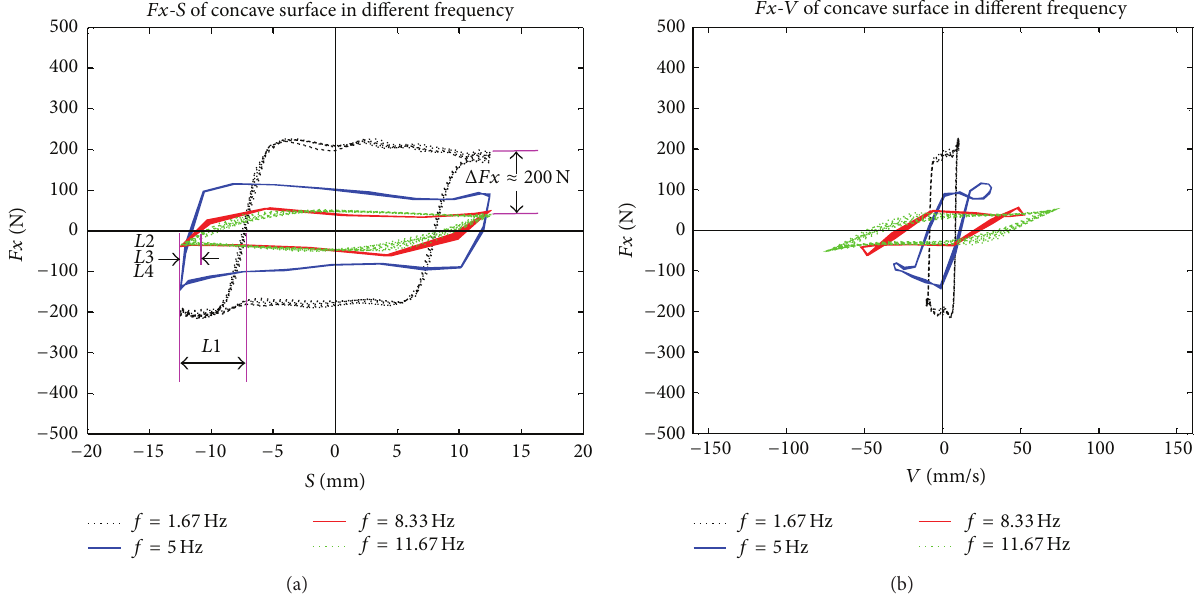
Figure 11: The patterns of (a) relative displacement and (b) relative velocity during the stable friction process of concave surface at four different reciprocating